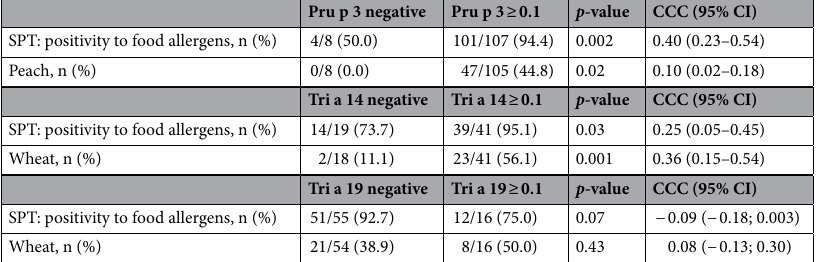
Table 6. Relationship between diagnostic results in vivo and in vitro.